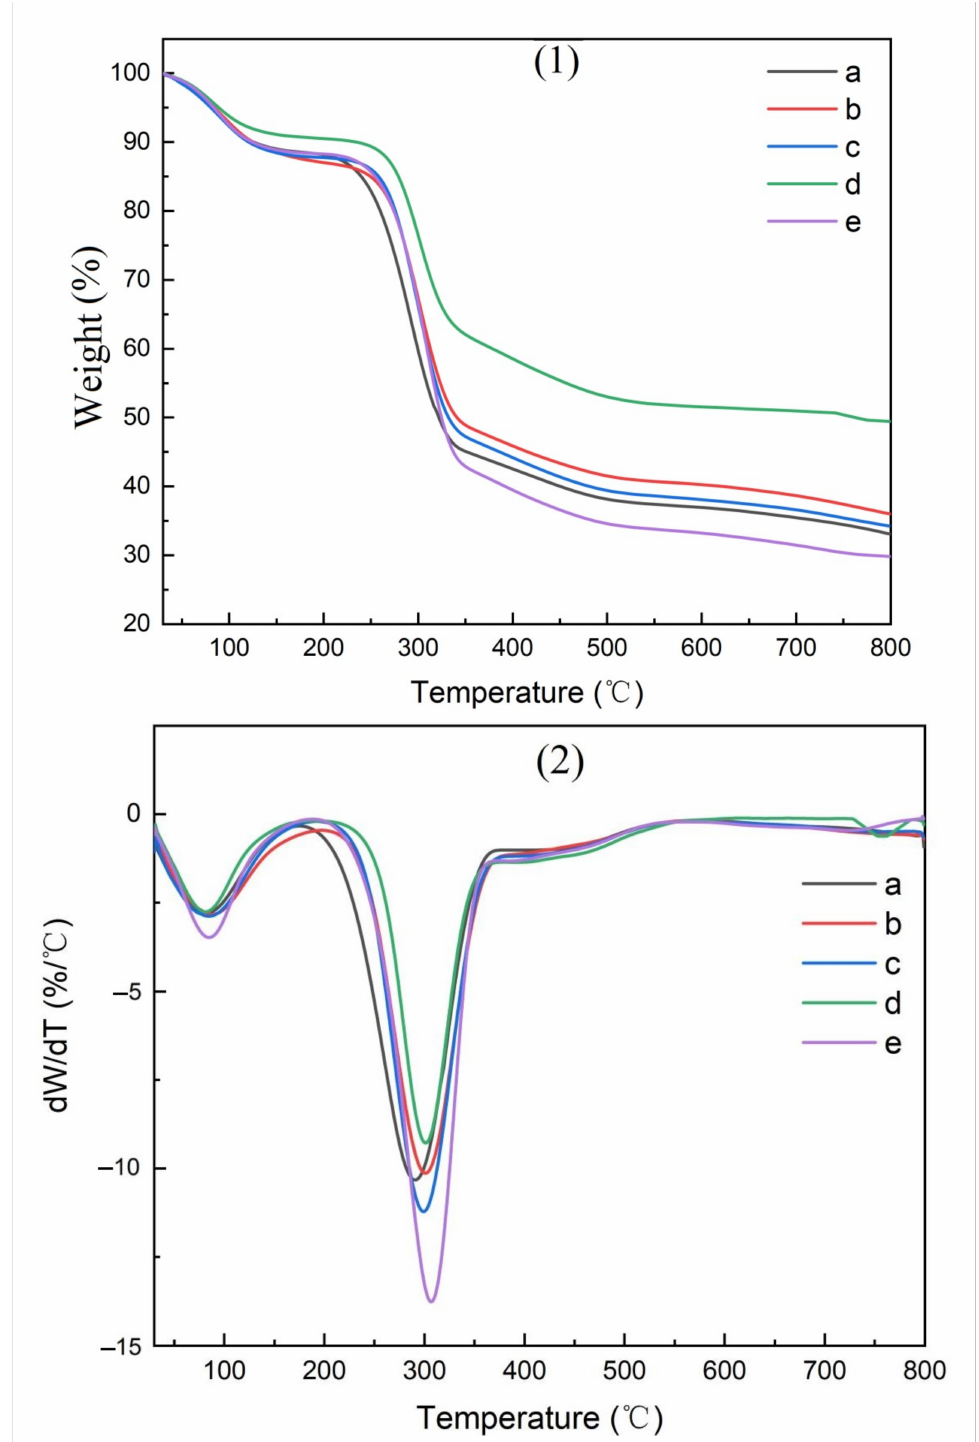
Figure 12. TG curves of CMCs derived from (a) pine wood, (b) bamboo culm, (c) pine needles, (d), bamboo leaves, or (e) hemp hurd, shown as thermogravimetric analysis ( 1 ) or differential thermogravimetric analysis ( 2